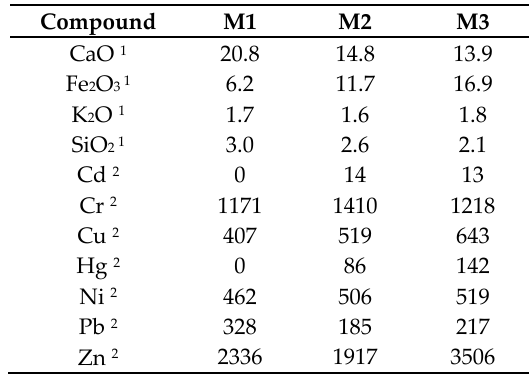
Table 3. Composition of chars produced during gasification